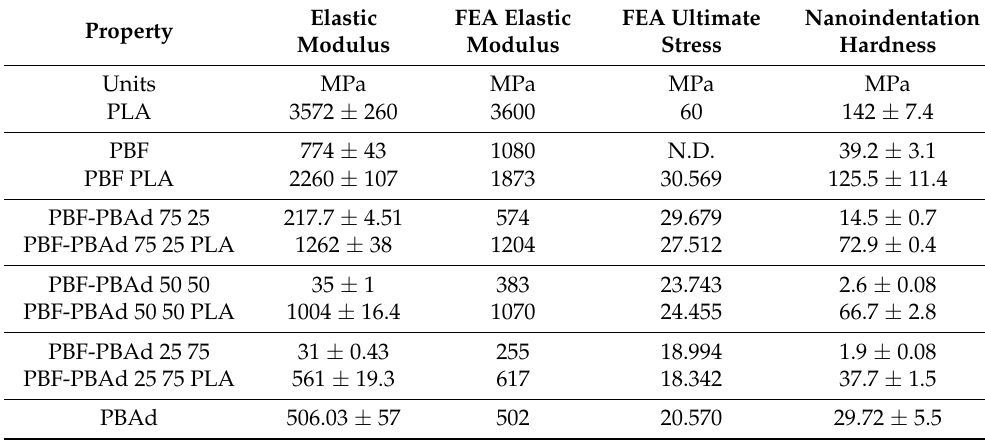
Figure 6. FEA generated stress–strain curves of ( a ) PBF, PBAd and PBF-co-PBAd, ( b ) PBF-PBAd PLA blends. Table 3. Mechanical properties of the homopolymers, copolymers and blends obtained using nanoin- dentation and FEA-assisted